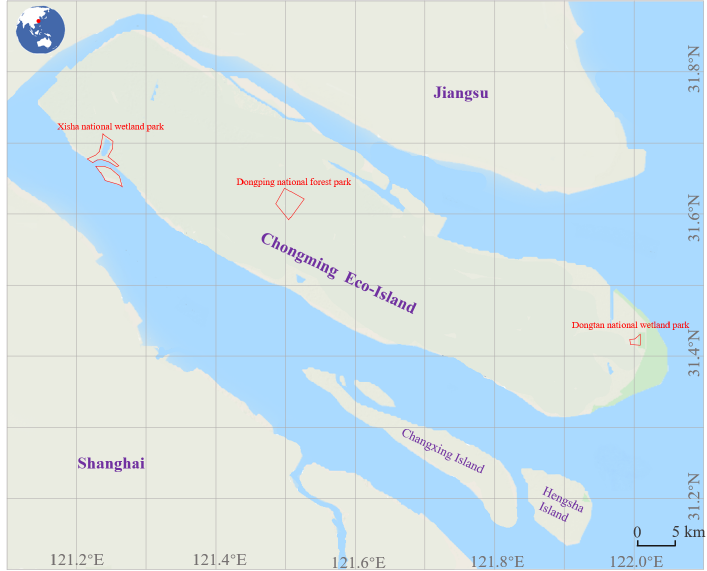
Figure 1. This figure shows Chongming eco-island and all three strictly protected forest-based eco-tourism areas that were chosen for quantifying forest change in the island. The detailed locations used for quantitative research are labeled with red polygons, namely Dongtan National Wetland Park, Xisha National Wetland Park, and Dongping National Forest